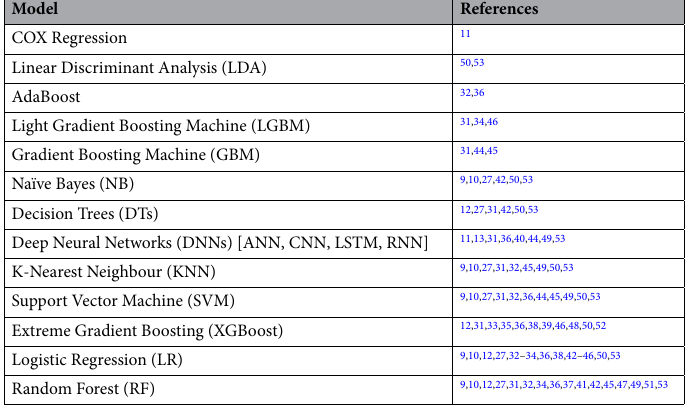
Table 1. Summary of machine learning prediction models for COVID-19 diagnosis.